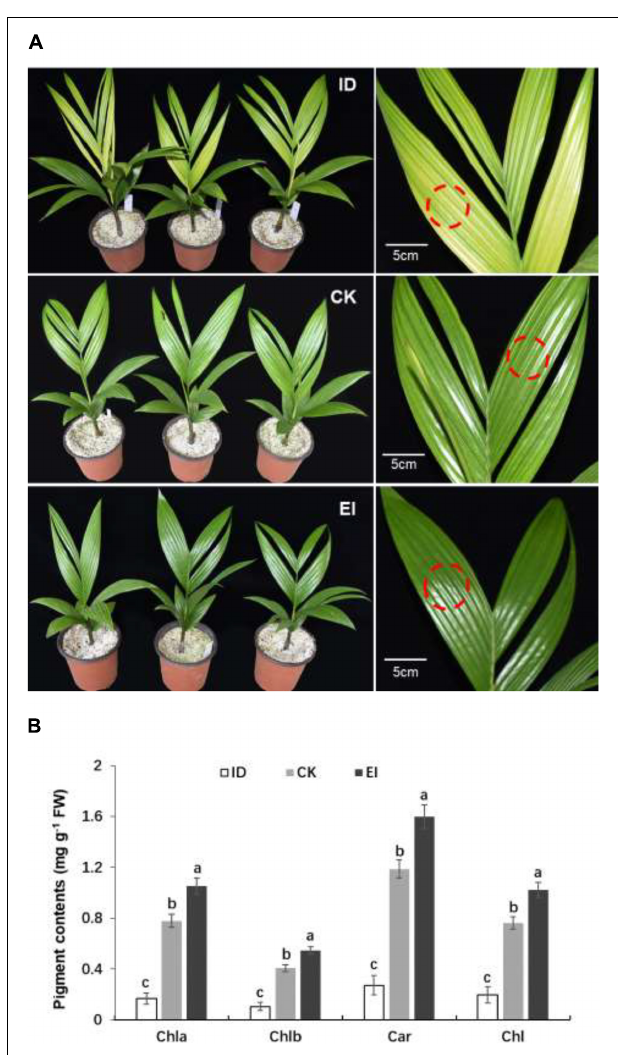
FIGURE 1 | Morphological characteristics (A) and pigment content (B) of A. catechu seedlings grown under ID (0.5 µ M Fe-EDTA), CK (50 µ M Fe-EDTA), and EI (150 µ M Fe-EDTA). ID, iron-deficiency treatment; CK, normal conditions; EI, excessive-iron treatment. Chla, chlorophyll a ; Chlb, chlorophyll b ; Car, carotenoid; Chl, chlorophyll a + chlorophyll b ; red dashed circles represent the sampling areas. The small bars show standard deviation. Different letters represent significant differences at P < 0.05 according to Duncan’s multiple range